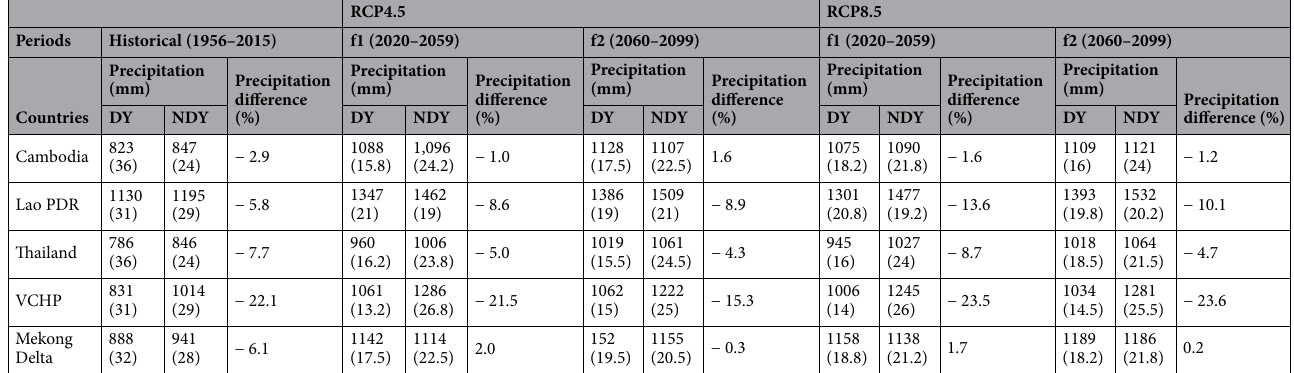
Table 1. Total precipitation amount during crop growing season for the historic and future periods and differences between drought and non-drought year (Average of four GCMs). The numbers in the bracket indicate the average number of drought and non-drought years for four GCMs. Negative values indicate the decreases in precipitation during drought years. DY Drought year, NDY Non-drought year, VCHP Vietnam Central High Plain.